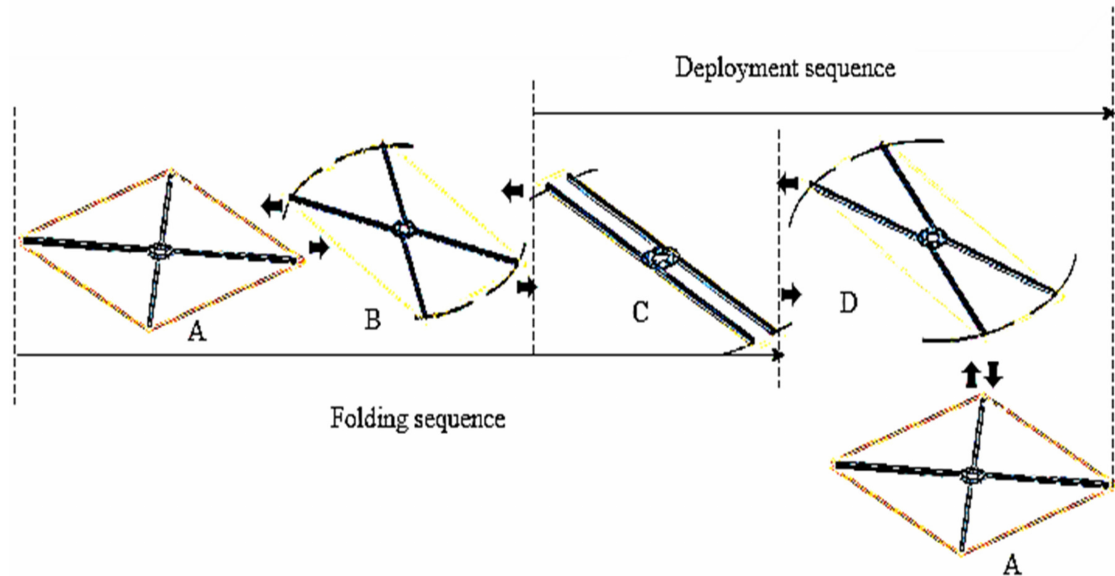
Figure 5. Folding and unfolding sequence of the MUAV